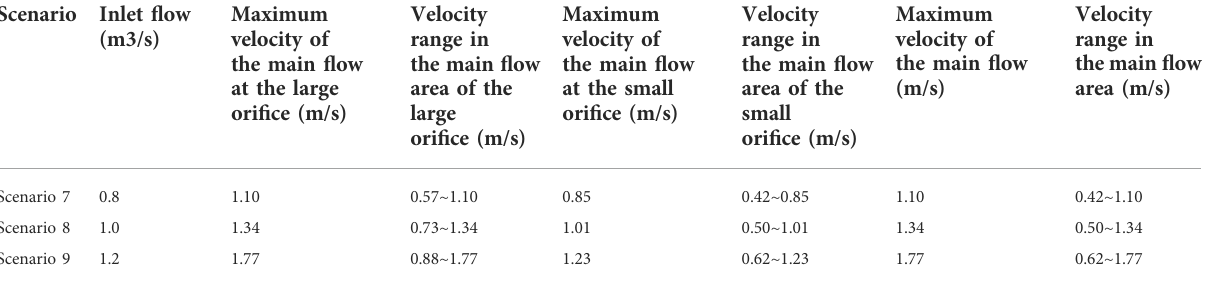
Figure 14F is the turbulent kinetic energy distribution cloud diagram at the middle position of a small pore in a typical cell under scenario 9. At the bottom ori fi ce, the turbulent kinetic